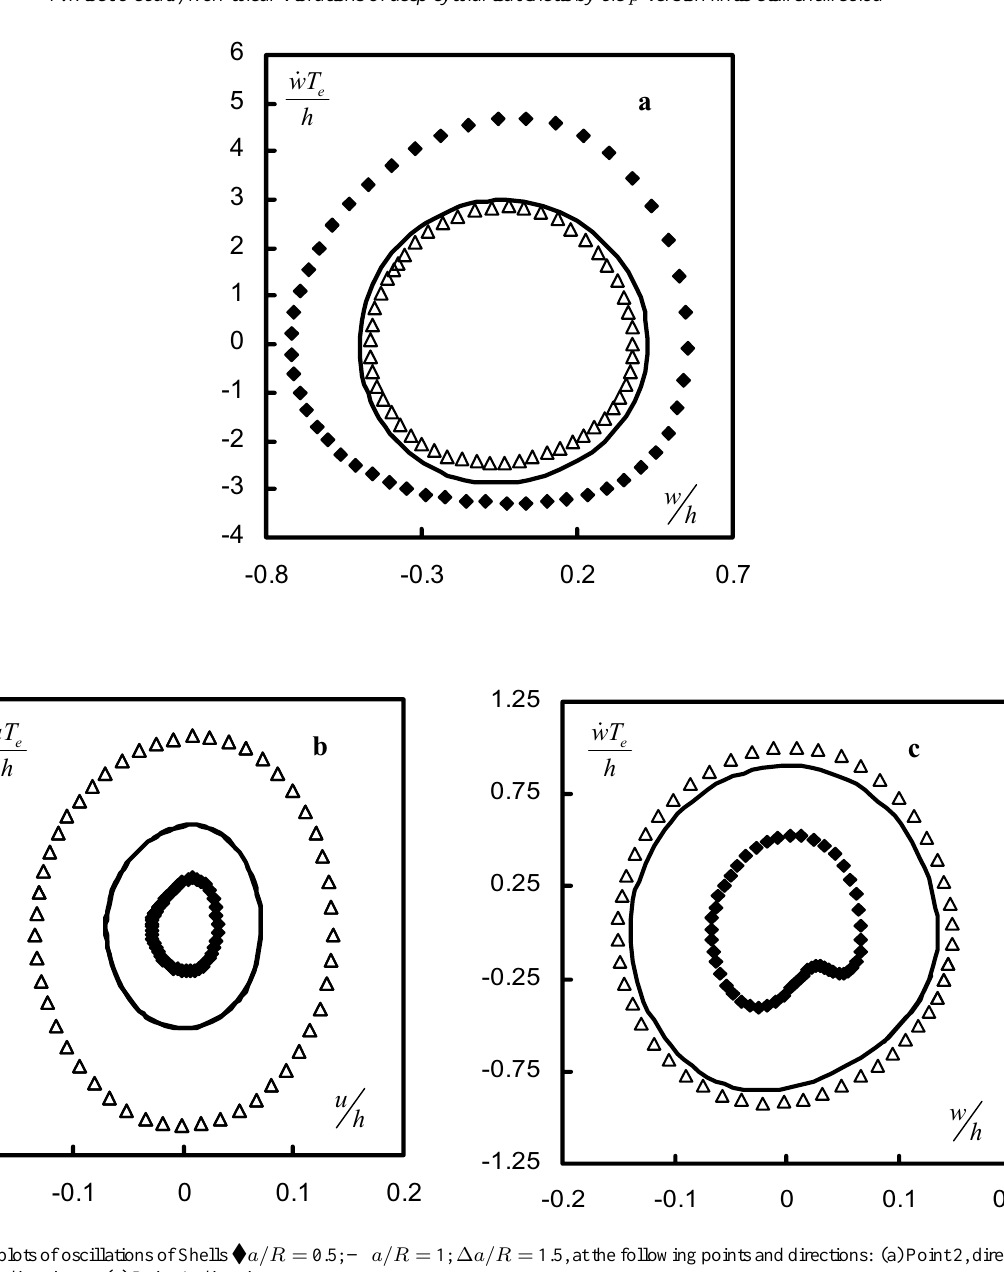
Fig. 7. Phase plots of oscillations of Shells (cid:2) a/R = 0.5; — a/R = 1; ∆ a/R = 1.5, at the following points and directions: (a) Point 2, direction z ; (b) Point 1, direction x ; (c) Point 1, direction z . also the same for the three shells, but their global, physical coordinates naturally depend on the curvature radius of each